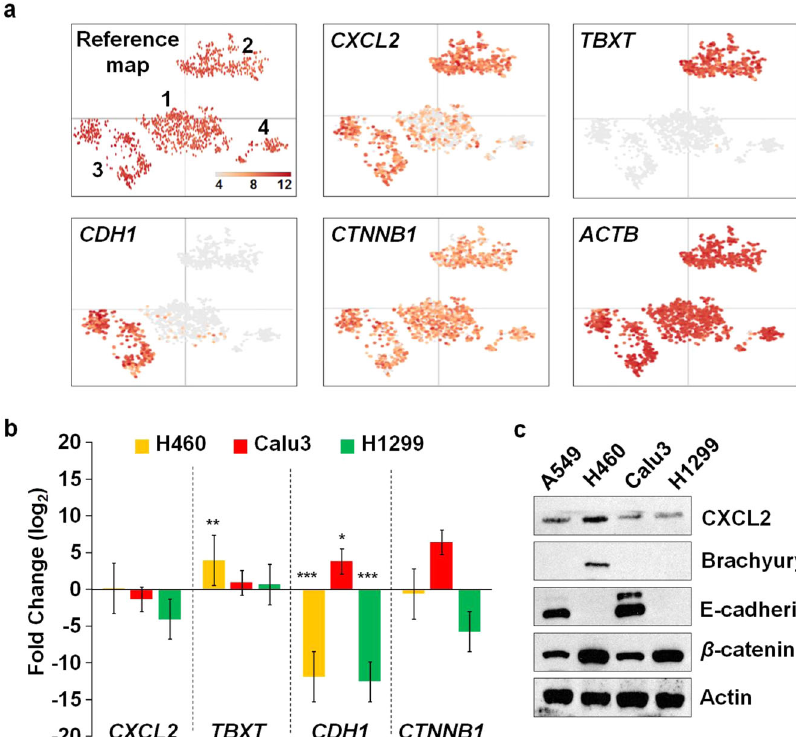
Fig. 8 Validation of selected gene expression at protein level. a Expression maps presenting differential expression of 4 selected scRNA-seq DEGs ( CXCL2 , TBXT , CDH1 , and CTNNB1 ) and ACTB (control gene) at single-cell resolution with a reference expression map. b qRT-PCR validation of fold-change values for the 4 selected DEGs at bulk-cell level; H460 (orange bars), Calu3 (red bars), and H1299 (green bars) compared with A549 (control cell line). X and y axes indicate gene names and fold-change values (log 2 ), respectively. Fold-change values expressed as mean ± SEM from three separate experiments conducted in duplicate. Statistical signi fi cance; * P < 0.05, ** P < 0.01, and *** P < 0.001. c Western blot analysis showing expression of proteins encoded by the 4 selected DEGs and Actin (loading control) in the four human NSCLC epithelial cell